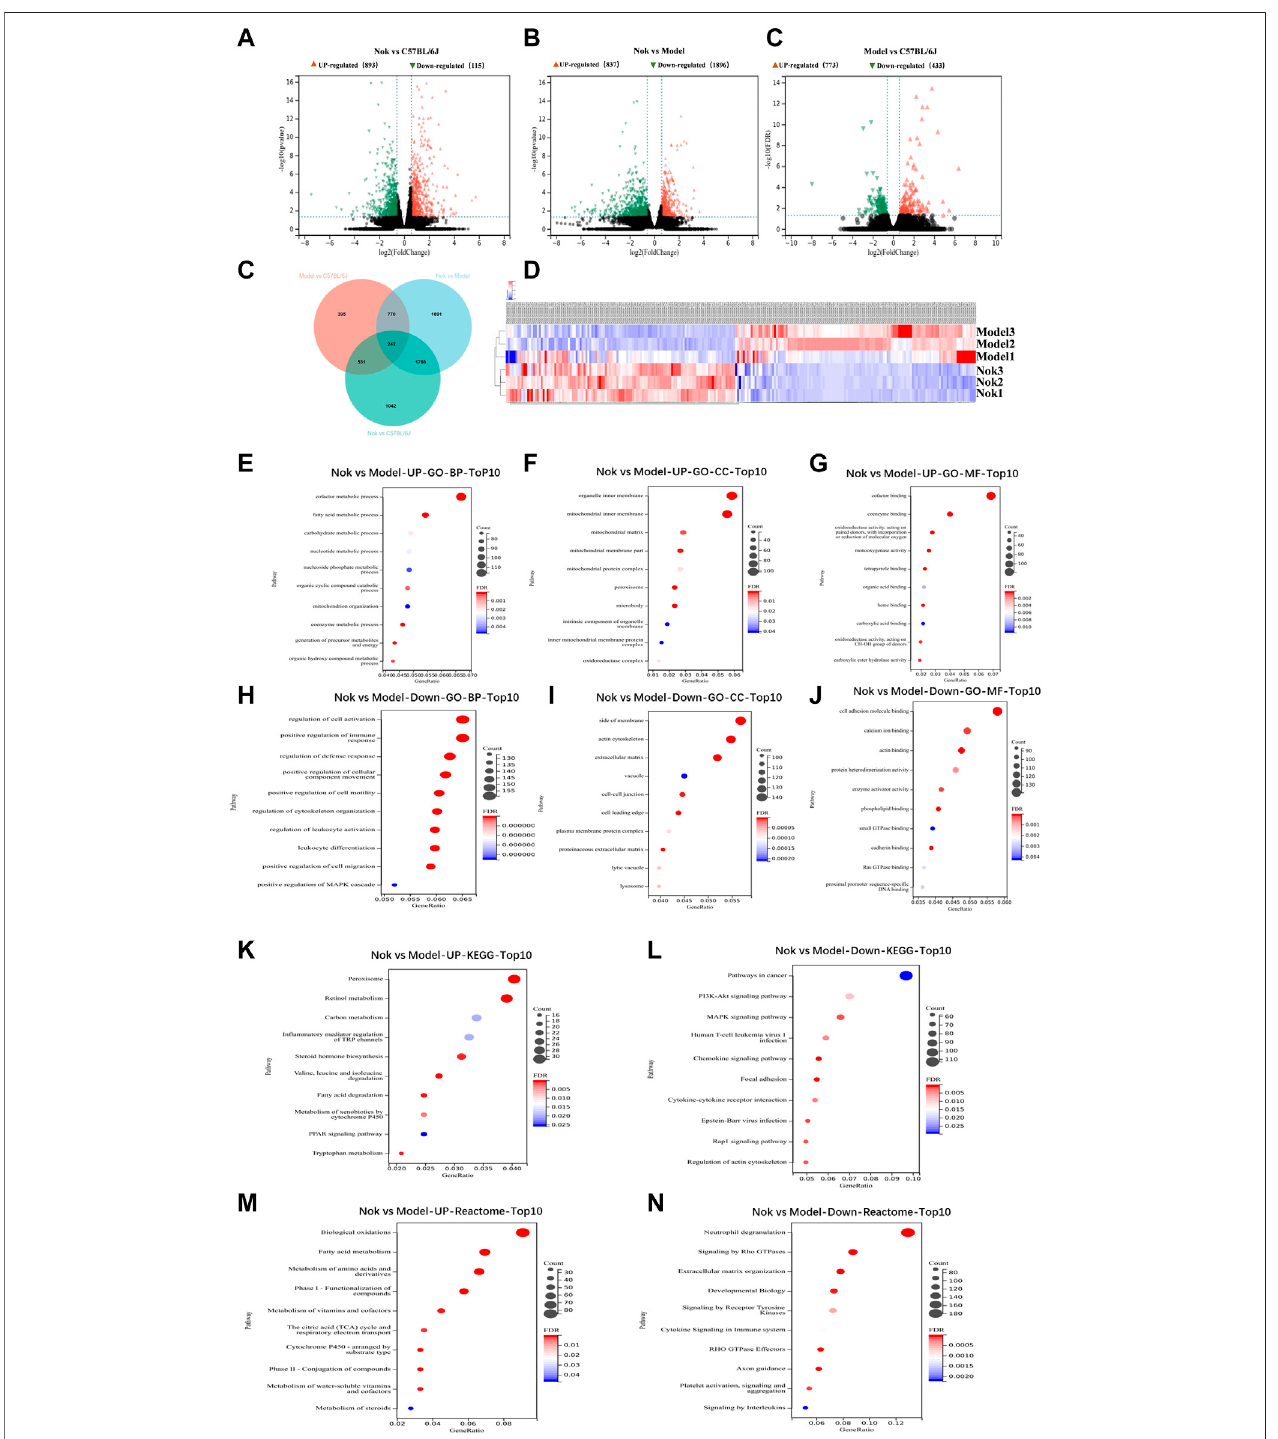
FIGURE 3 | Analysis of hepatic transcriptome . RNA-seq assay of mouse hepatocytes between the Nok treatment group (n = 3) and MAFLD model group (n = 3). Volcano plots show the differentially expressed genes in (A) Nok-treated vs. normal mice, (B) Nok-treated vs. MAFLD mice, and (C) MAFLD vs. normal mice show fold changes(|log 2 (foldchange)| > 0.58andadjusted p valuepadj ≤ 0.05). (D) Venndiagramshowingtheintersectionsamongdifferentiallyexpressedgenesindifferentgroup- to-groupcomparisons. (E) HeatmapshowingthedifferentiallyexpressedgenesbetweenNok-treatedandMAFLDmodelmice. (F – K) GeneOntology(GO)analysis showing the main changes in gene functions between Nok-treated and MAFLD model mice. (L – M) Kyoto Encyclopedia of Genes and Genomes (KEGG) showing enriched differentially expressed genes belonging to different pathways between Nok-treated and MAFLD model mice. (N – O) The Reactcomes of the main changes of gene functions between Nok treated and MAFLD model